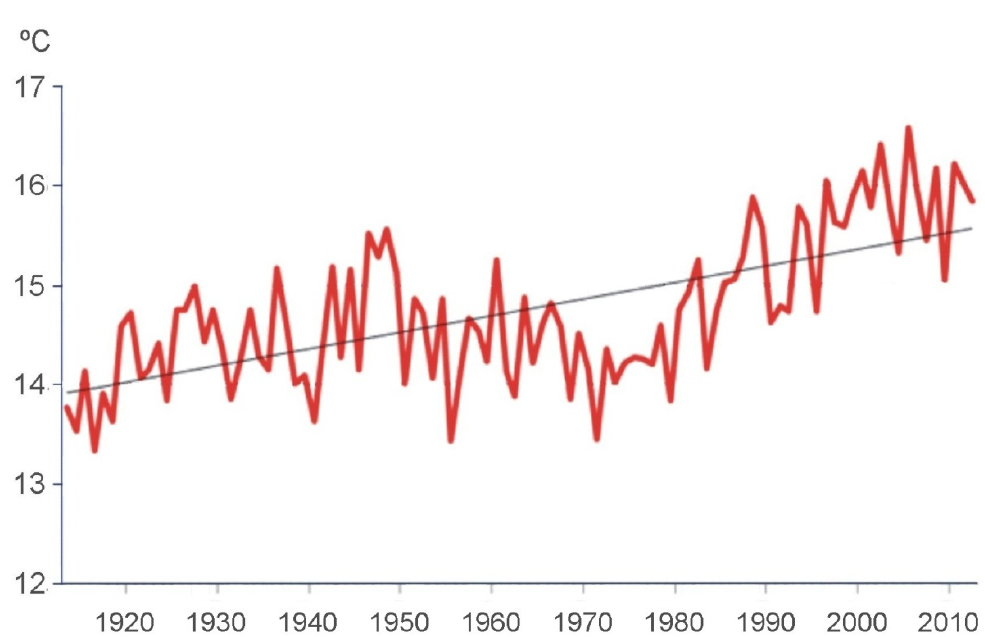
Figure 6. Evolution and linear trend of the average annual temperature for the first century of records of the Fabra Obser- vatory (1914–2013), in °C. Source: RACAB and Martín-Vide, 2017.